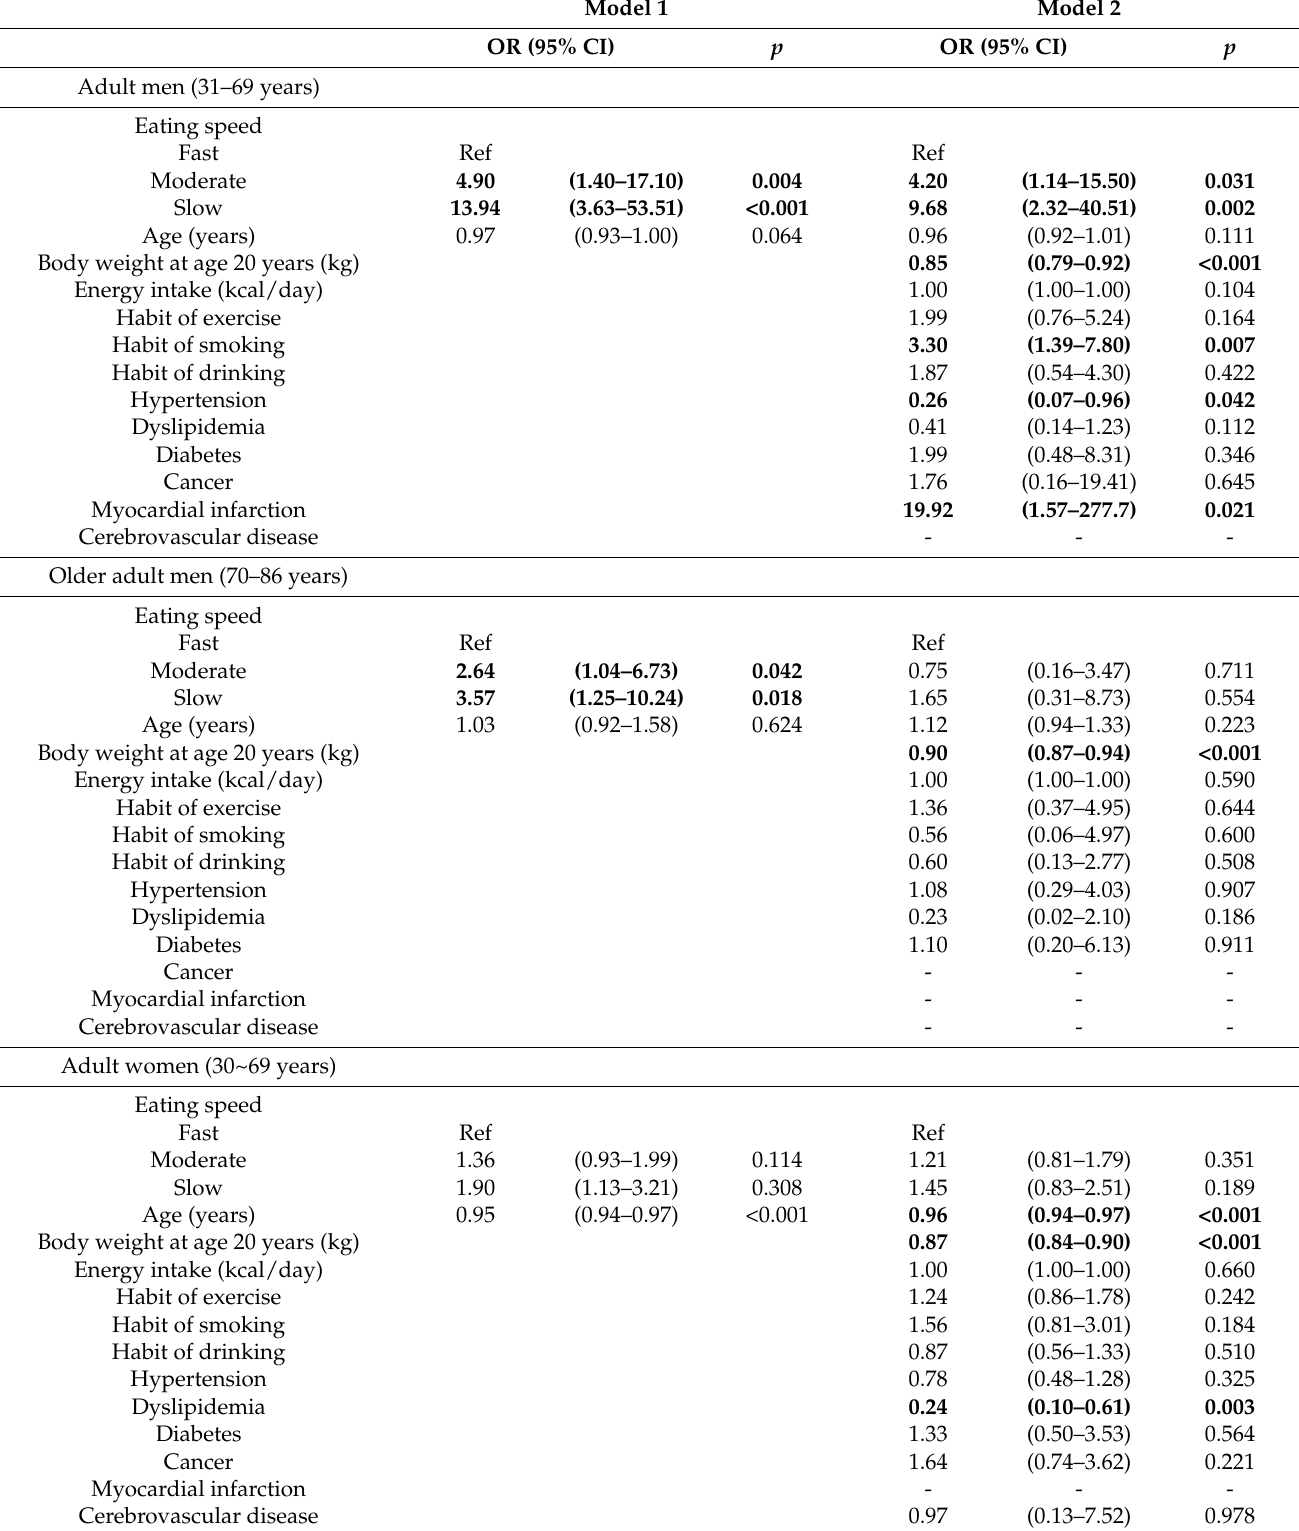
Table 2. Logistic regression analysis on the prevalence of undernutrition according to sex and age